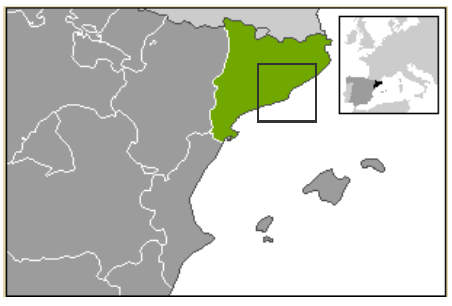
Figure 1: The Autonomous Community of Catalonia.